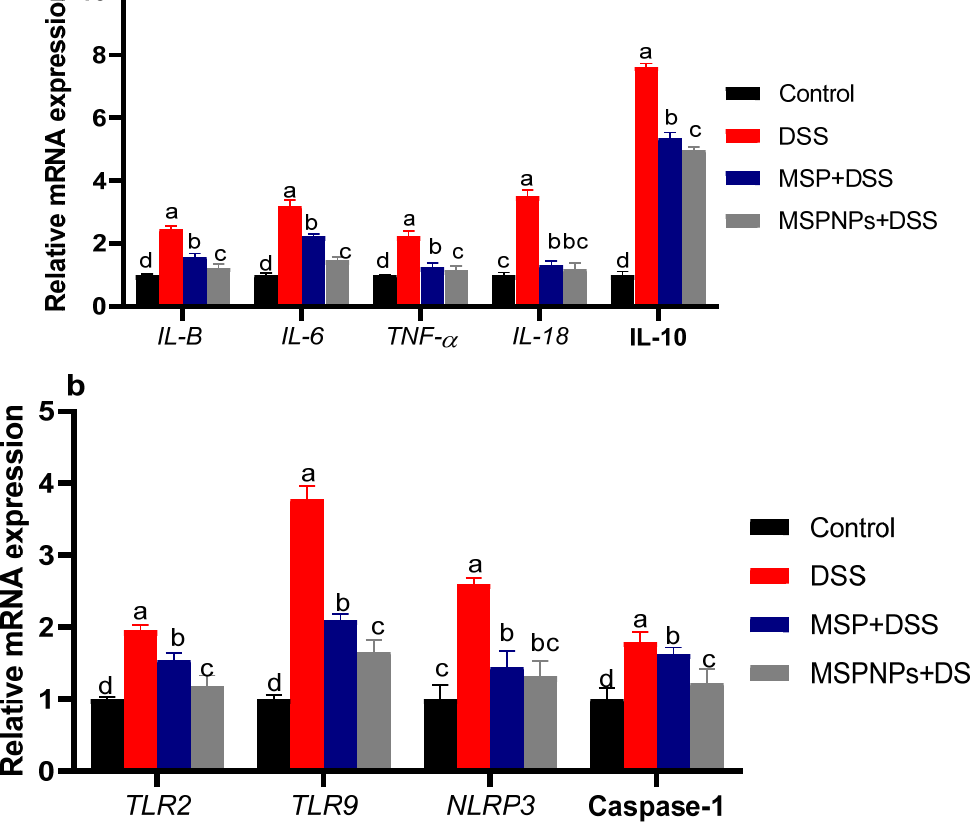
Figure 4. Effects of orally administered free multi-strain probiotics (MSPs) or multi-strain-probiotic- loaded nanoparticles (MSPNPs) on: ( a ) mRNA expressions of cytokine-related genes, Interleukin (IL)-1 β , IL-6, IL-18, IL-10 and tumor necrosis factor α (TNF α ); ( b ) expressions of toll-like receptors (TLR2 and TLR9) pyrin domain-containing protein 3 (NLRP3) inflammasome and caspase-1 at 14 days post DSS induction. Non-colitic group: Control (rats were orally gavaged with PBS). Colitic groups including: DSS (rats were orally gavaged with dextran sodium sulphate), DSS + MSPs (rats were orally gavaged with DSS and multi-strains probiotics (MSPs) at the level of 1.0 × 10 10 CFU/kg in 1 mL of PBS/rat/day for 14 days), DSS + MSPNPs (rats were orally gavaged with DSS and multi- strain-probiotic-loaded nanoparticles (MSPNPs) at the level of 1.0 × 10 10 CFU/kg in 1 mL of PBS/rat/day for 14 days); all groups were orally gavaged with 5% DSS. Values are expressed as mean ± SE. a,b,c,d Means of the bars with different letters were significantly different among groups ( p < 0.05).